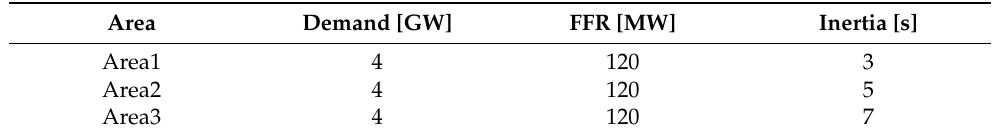
Table 1. Three-area test system